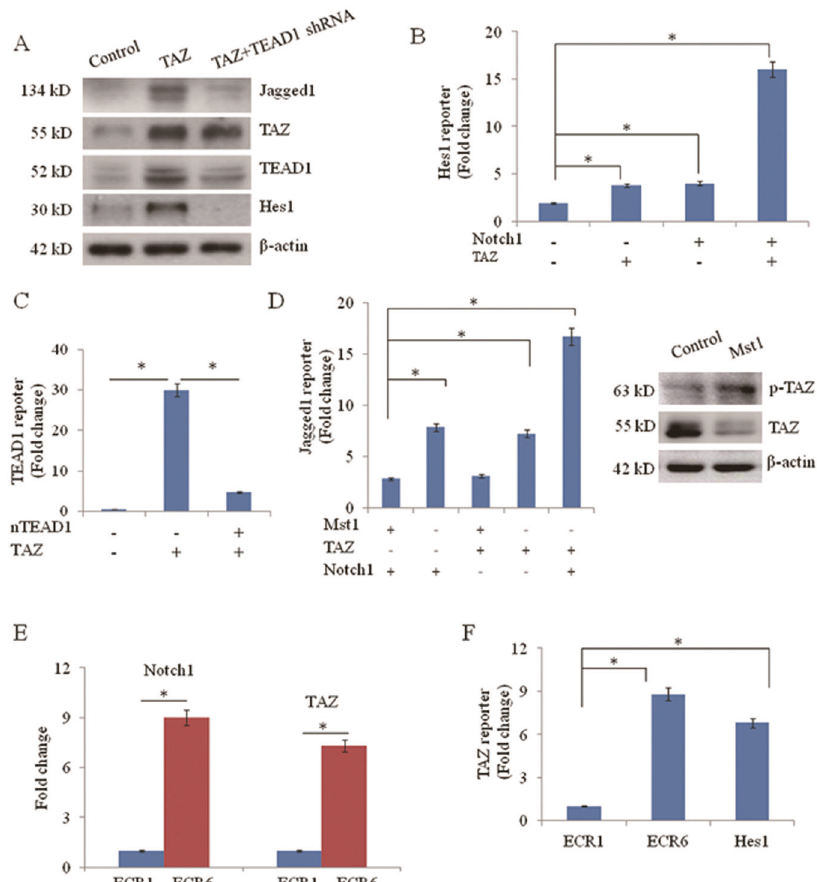
Fig. 4 TAZ regulates Jagged1 in a TEAD1-dependent manner. a Protein analysis of Jagged1, TAZ, TEAD1, and Hes1 in A549 cell lysates after transfected with TAZ and concomitant silencing of TEAD1 by shRNA. b Hes1 reporter assay in the presence ( + ) or absence ( − ) of Notch1 ICD, or TAZ, N = 3. Results of luciferase reporter assays are shown. * P < 0.05. c TEAD1-reporter luciferase assay in the presence ( + ) or absence ( − ) of TAZ or nTEAD1, N = 3. d Jagged1 luciferase reporter assay in the presence ( + ) or absence ( − ) of Notch1 ICD, TAZ, or Mst1, N = 3. * P < 0.05. Cells were transfected with or without MST1, phosphorylated TAZ and TAZ were analyzed by western blot assay. e ChIP assay for Notch1 or TAZ in A549 cells transfected with Notch1, TAZ, and plasmid of either Jagged1-ECR1 or ECR6. Data are presented as fold enrichment over an IgG ChIP performed with the same samples. f ChIP assay for TAZ in A549 cells at Jagged1-ECR1, ECR6, and Hes1 promoter. N = 3. * P < 0.05.